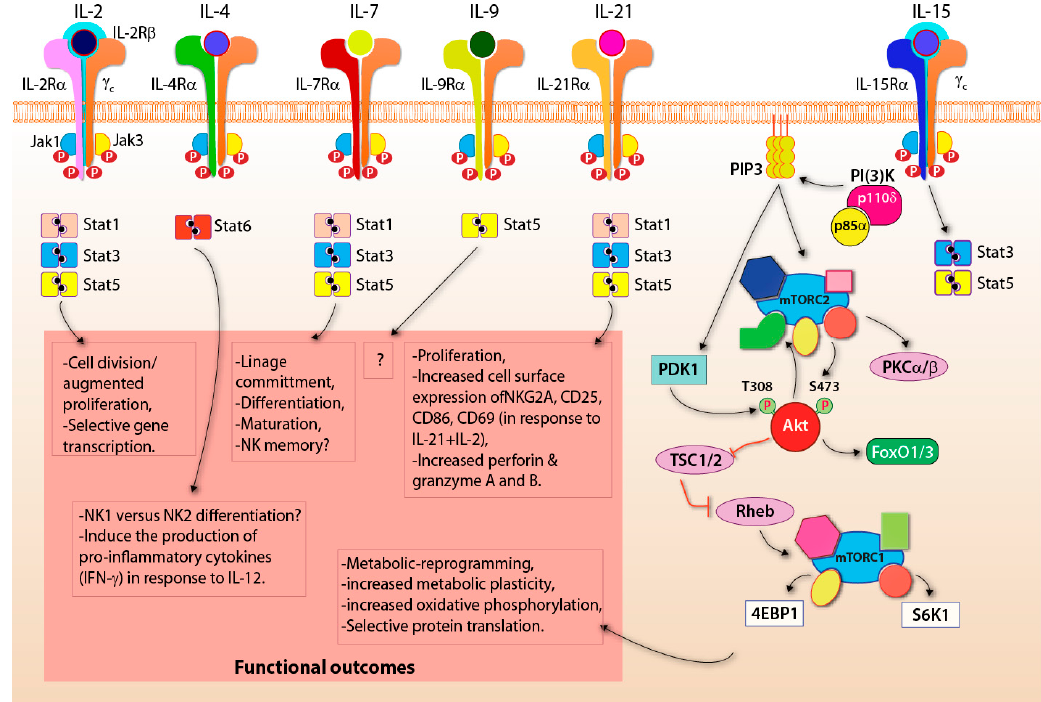
Figure 5. Activation via common γ cR constitutes ‘secondary signaling’. Downstream signaling of the common gamma receptor ( γ cR) family is shown. IL ‐ 2, IL ‐ 4, IL ‐ 7, IL ‐ 9, IL ‐ 21, and IL ‐ 15 activate Janus Kinases 1/3 (JAK), which undergo ( γ cR) family is shown. IL-2, IL-4, IL-7, IL-9, IL-21, and IL-15 activate Janus Kinases 1/3 (JAK), which undergo receptor ‐ mediated phosphorylation. Signal transducer activating transcripts (STAT) are recruited and phosphorylated. Dimerization of phosphorylated STAT translocates to the nucleus to promote various functional outcomes. Also, IL ‐ 15 can signal via PI(3)K promoting the conversion of phosphatidylinositol 4,5 ‐ bisphosphate (PIP 2 ) to phosphatidylinositol 3, 4,5 ‐ bisphosphate (PIP 3 ), which activates the mammalian target of rapamycin complex 1 (mTORC1) signaling cascade.